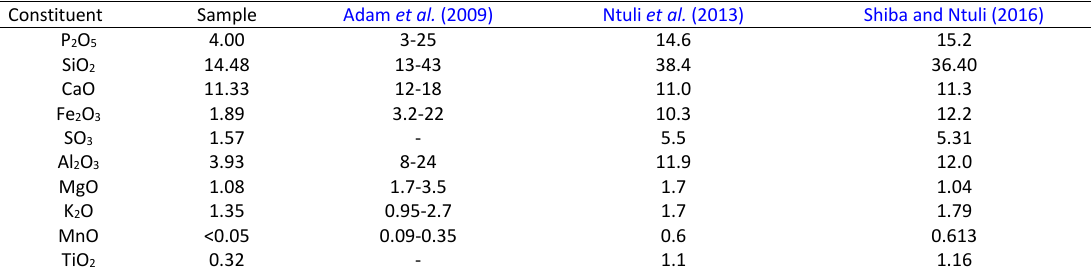
Table 3: Chemical composition of sewage sludge